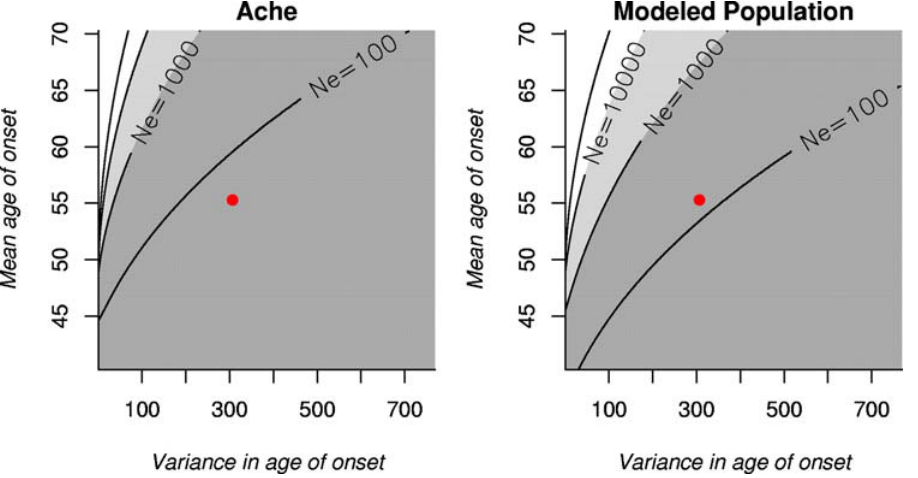
Figure 4. Selection on late-onset diseases for the Ache and the modeled population. As in Figure 3C but using survival and fertility for Ache (left panel) and the modeled population (right